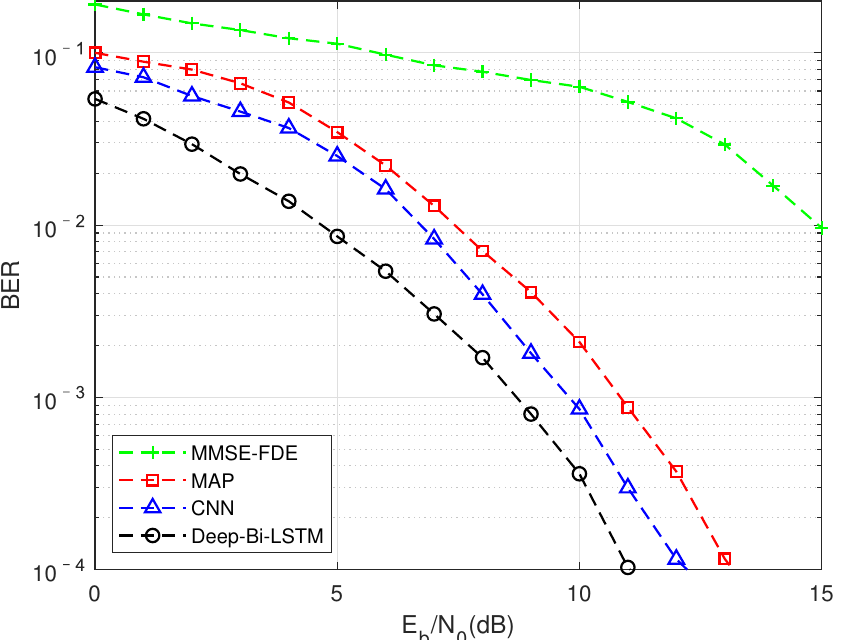
Figure 15. FTN detection performance of different algorithms is obtained by using QPSK (4QAM) modulation, MMSE equalization and compression factor τ = 0.8 in TU